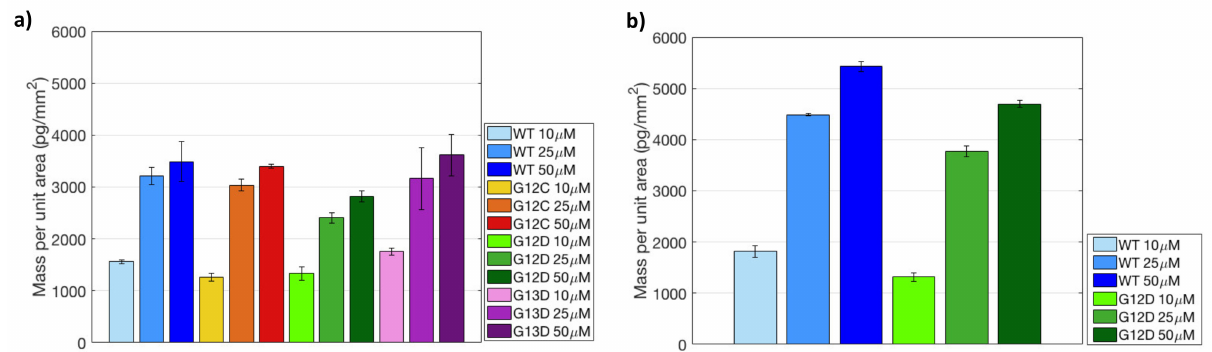
Figure 6. Immobilized mass of the probes spotted on ( a ) MCP-4 and ( b ) Copoly Azide 10% coated chips, obtained by analyzing the IRIS images of Figure 5.